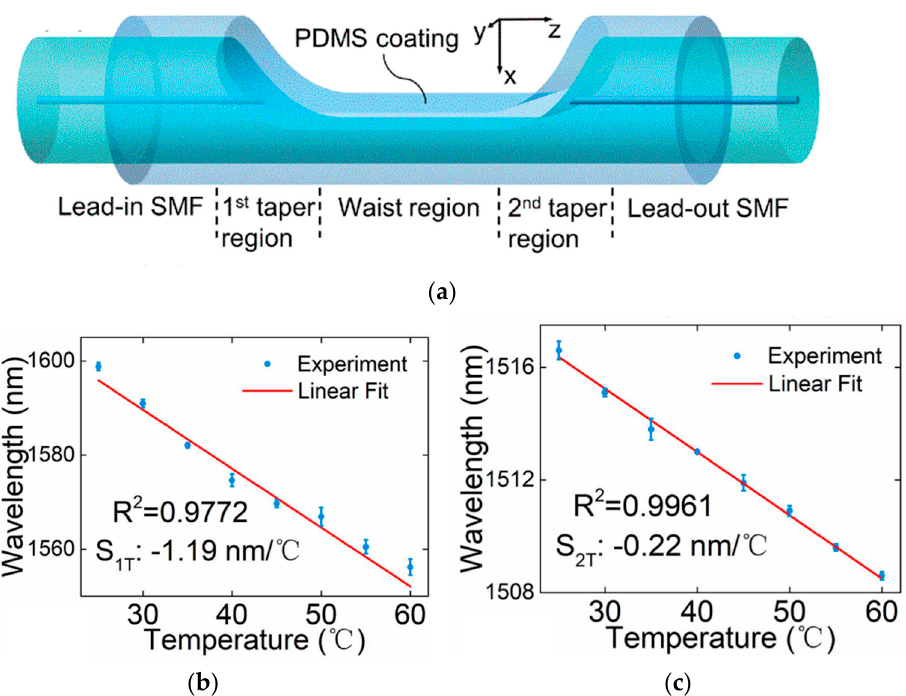
Figure 6. MZ type temperature sensor: ( a ) schematic diagram of coated microcavity; ( b ) relationships between wavelength dip on the transmission spectrum and temperature; ( c ) relationships between wavelength peak on the transmission spectrum and temperature.